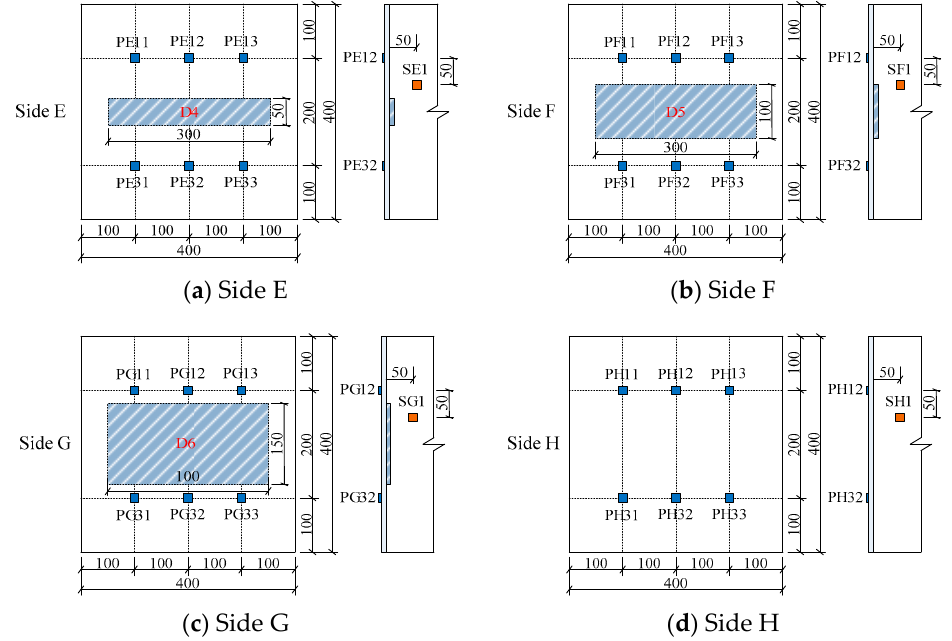
Figure 5. Arrangement of PZT patches, SAs and debonding defects in specimen No. 2 (unit: mm).